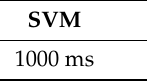
Table 3. Experiment results in algorithm detection time.